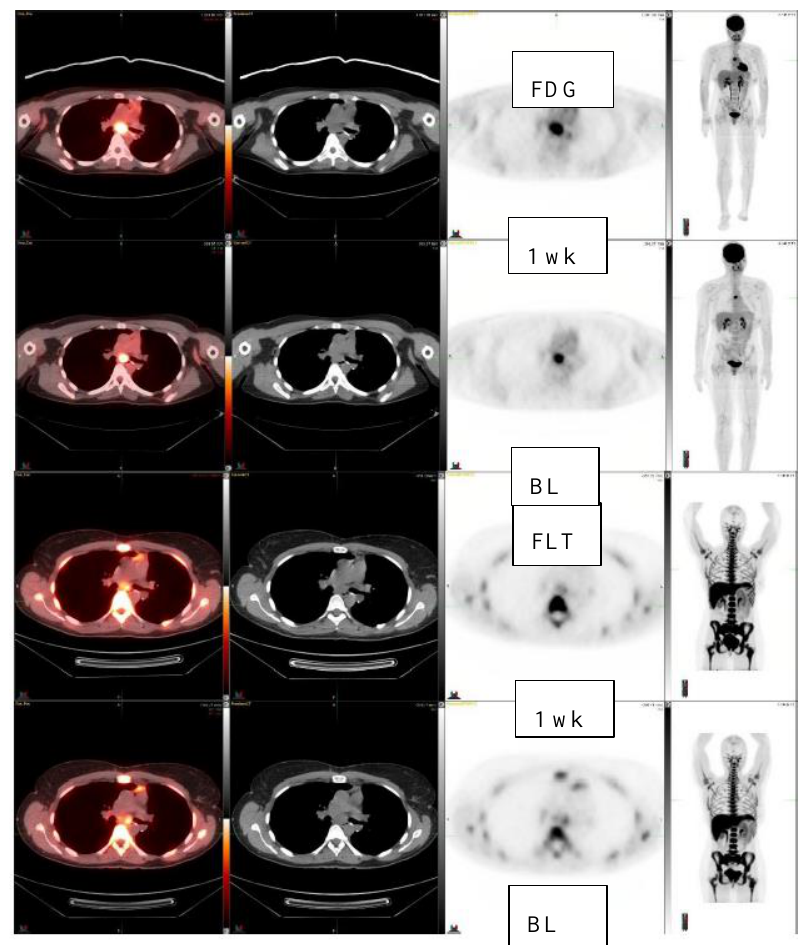
Figure 3. Clear cell sarcoma, left foot, lung resection. FDG-study at baseline and at 1 week (2 upper rows). FLT-study at baseline and at 1 week (2 lower rows). FDG-uptake increases 37% in a subcarinal lymph node: SUVmax 8.9 ->12.2, whereas FLT-uptake decreases 13%, FLT: SUVmax 3.0 ->2.6. On CT it becomes slightly bigger, CT: 2.2 cm × 1.2 cm ->2.3cm × 1.5 cm.